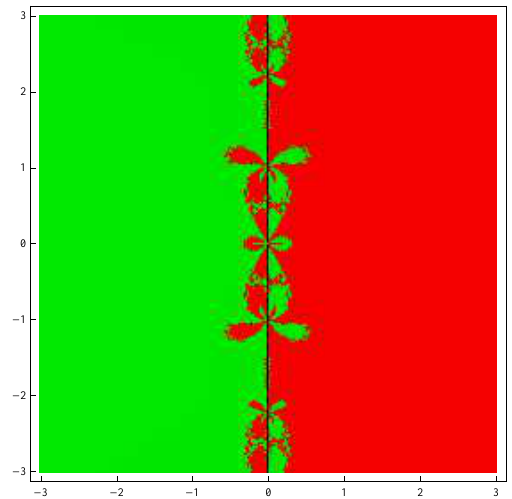
Figure 3. Basins of attraction of method (3) for test problem